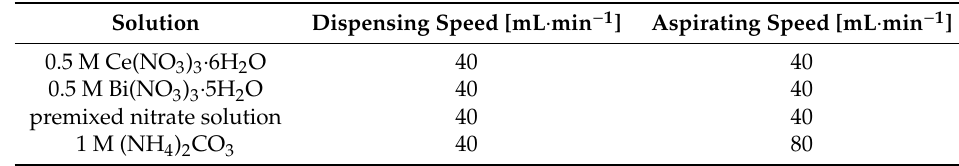
Table 1. Dispensing and aspirating speeds of the pipetting steps. The 4-needle head (4NH) of the synthesis robot Chemspeed Accelerator SLT106 is used for liquid